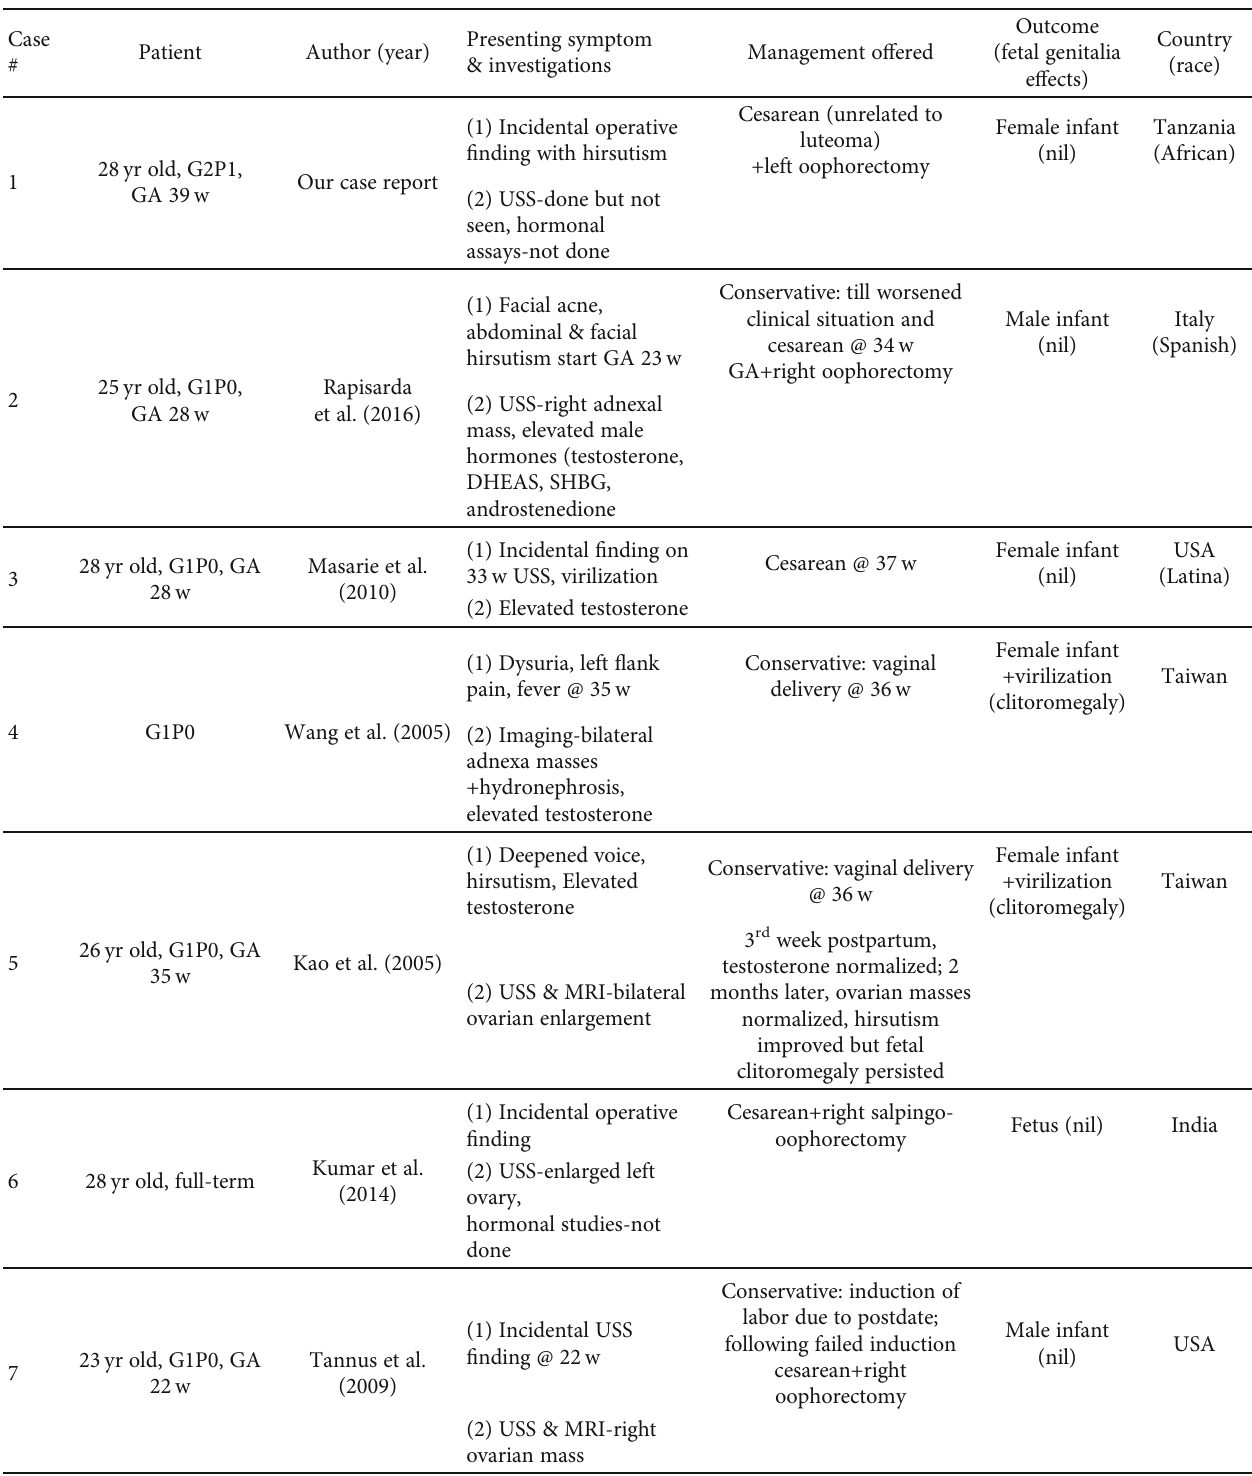
Table 1: Literature review of pregnancy luteoma case reports: from 2000 to